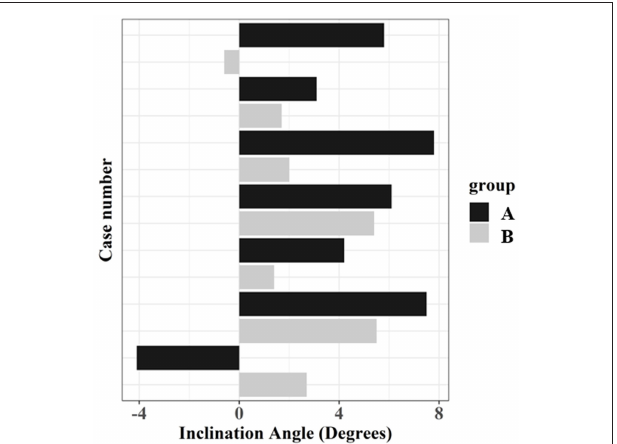
FIGURE 8 | Osteotomy inclination angle for the two groups. The direction of osteotomy proximally from the medial cortex to the lateral cortex is defined as a positive angle. In contrast, the direction of the osteotomy distally from the medial cortex to the lateral cortex is defined as a negative angle.